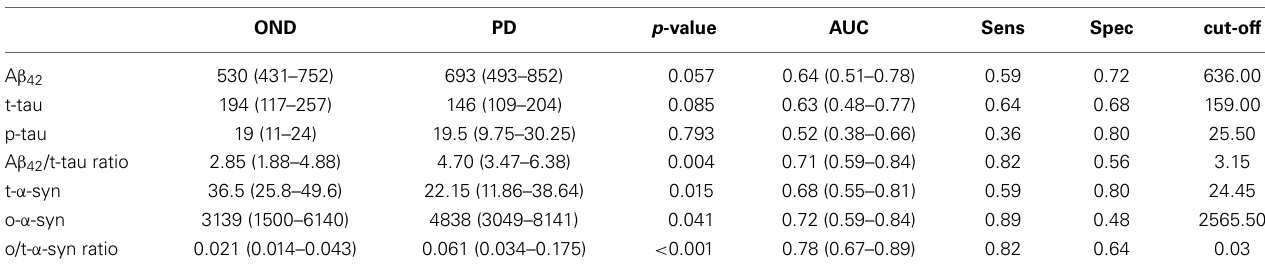
Table 2 | CSF biomarkers in PD and